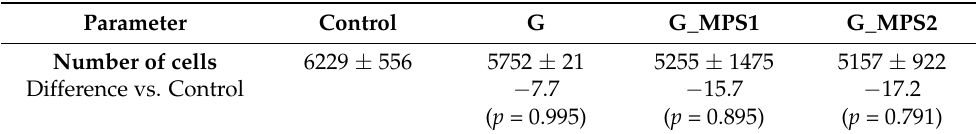
Table 3. Mean numbers of MC3-T3 cells ( ± SD) after 72 h cultured in direct contact with the bone cement reinforced with 0.1 wt.% of each filler; the difference and the p -value respecting the control mean value are also indicated.